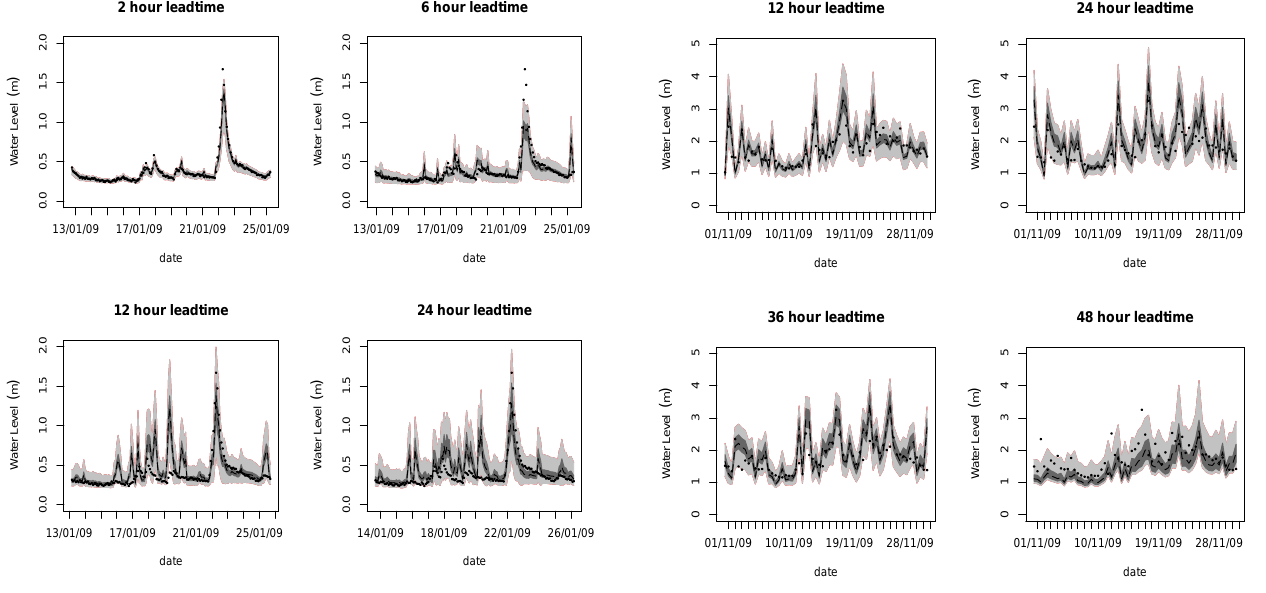
Fig. 6. Validation of Quantile Regression method for water level forecasts at Welshbridge (2077) for the November 2009 events for 12, 24, 36 and 48h leadtimes. The dark grey area represents the 50% confidence interval and the light grey area represents the 90% confidence interval, the black dashed line the 50% estimate, and the black dots the